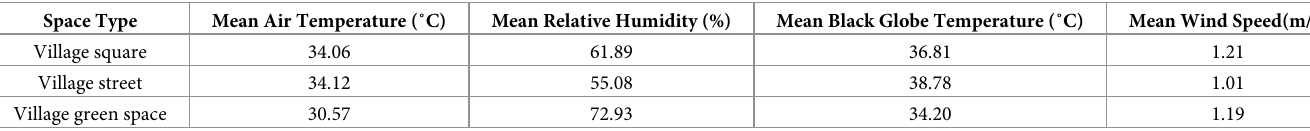
Table 4. Mean values of the microclimate parameters of different types of